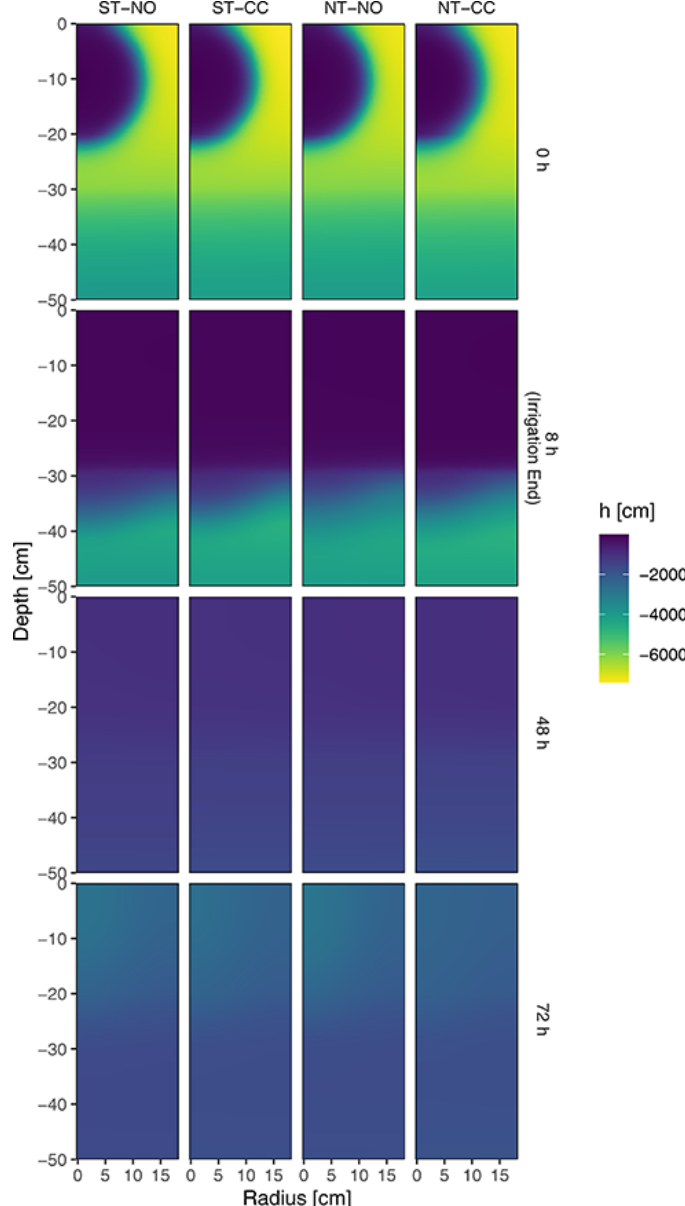
Figure A5. Hydraulic head distribution in the model domain at selected times during and after irrigation (treatment means).